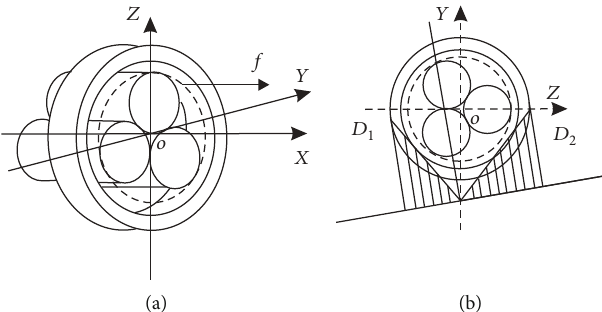
Figure 15: The mechanical analysis of the o ff -axial e ff ect at the contact location of the end anchor sleeve and the end steel load-bearing plate during the tensioning process of this large-tonnage BFRP anchor cable: (a) the mechanical illustration and (b) the loading distribution on the sectional area.